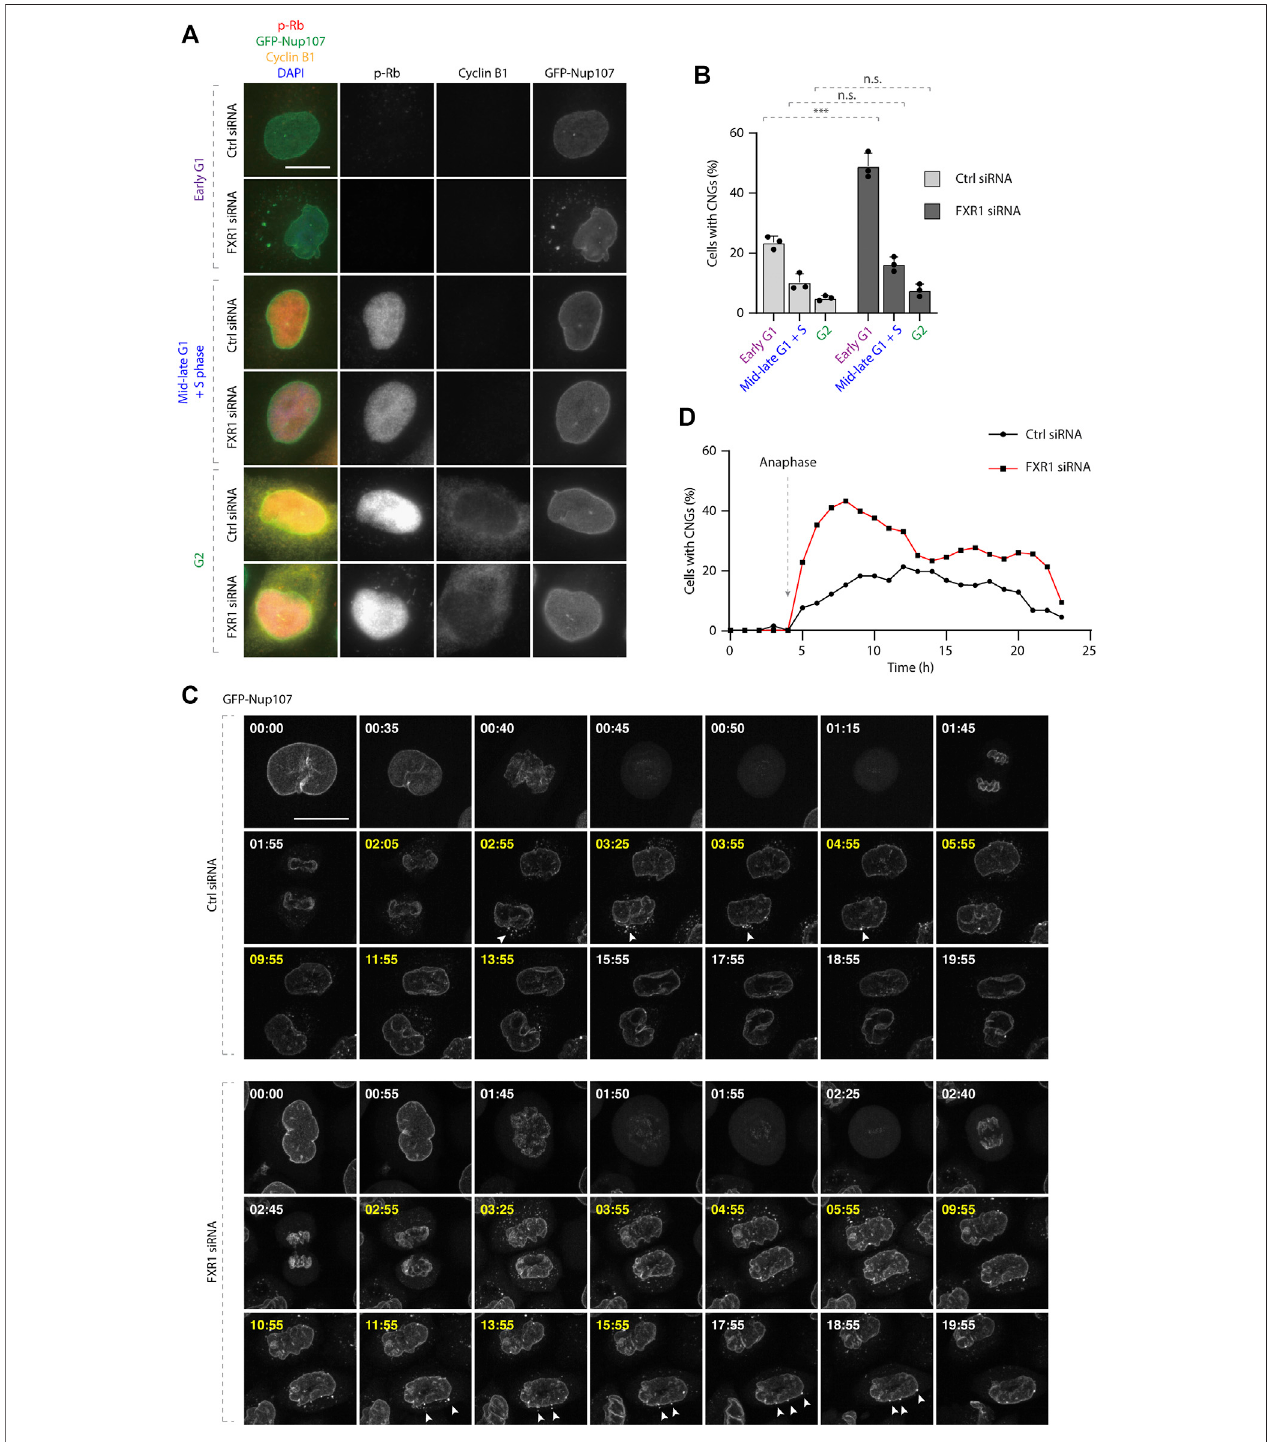
FIGURE 4 | CNGs are present speci fi cally during the G1 phase. (A – B) Asynchronously proliferating HeLa cells stably expressing GFP-Nup107 were treated with indicated siRNAs and analyzed by immuno fl uorescence microcopy (A) and the percentage of cells with cytoplasmic nucleoporin granules (CNGs) was quanti fi ed in different cell cycle stages. (B) 2,022 cells were analyzed (mean ± SD, *** p < 0.001; n.s. (cid:1) non-signi fi cant, N (cid:1) 3). (C – D) HeLa cells stably expressing GFP-Nup107 were treated with indicated siRNAs, synchronized by double thymidine block, and released and analyzed by live video spinning disk confocal microscopy starting 8 h after releaseand for24 h. (C) Selectedframesofthecorrespondingmovies (SupplementaryMovieS1and S2) aredepicted,and timeisshowninhours.Time frames marked with yellow indicate the presence of CNGs. White arrowheads point to the cytoplasmic GFP-Nup107 granules fusing with the NE. The percentage of cells with cytoplasmic GFP-Nup107 granules over time was quanti fi ed in (D) . 154 cells were analyzed, and the onsetofanaphase wasarti fi cially aligned at 4h for all movies; scale bars are 5 μ m.